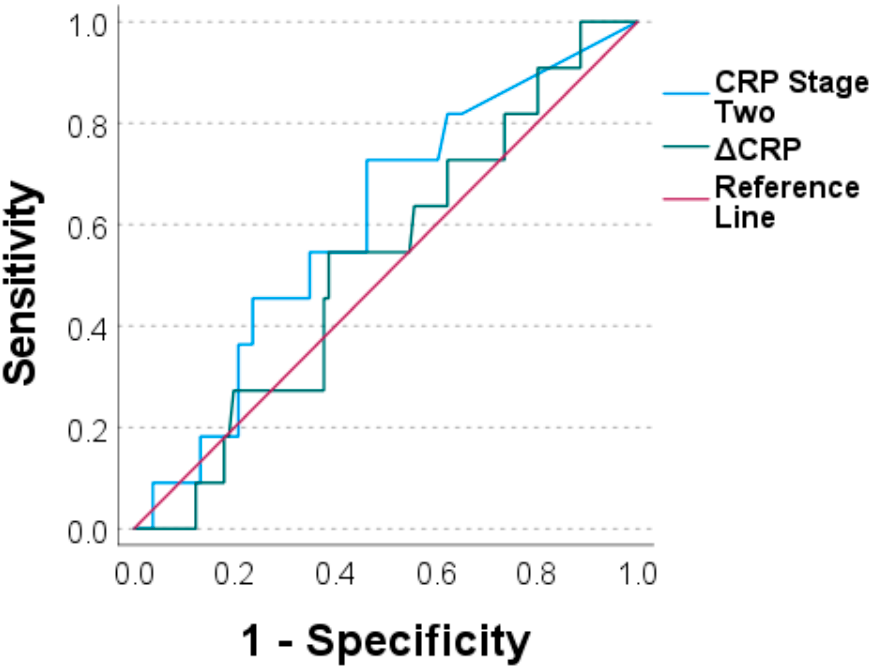
Figure 3. Receiver operating characteristic curves for C-reactive protein prior to stage two (“CRP stage two“) and for Δ CRP (CRP stage two minus CRP stage one).